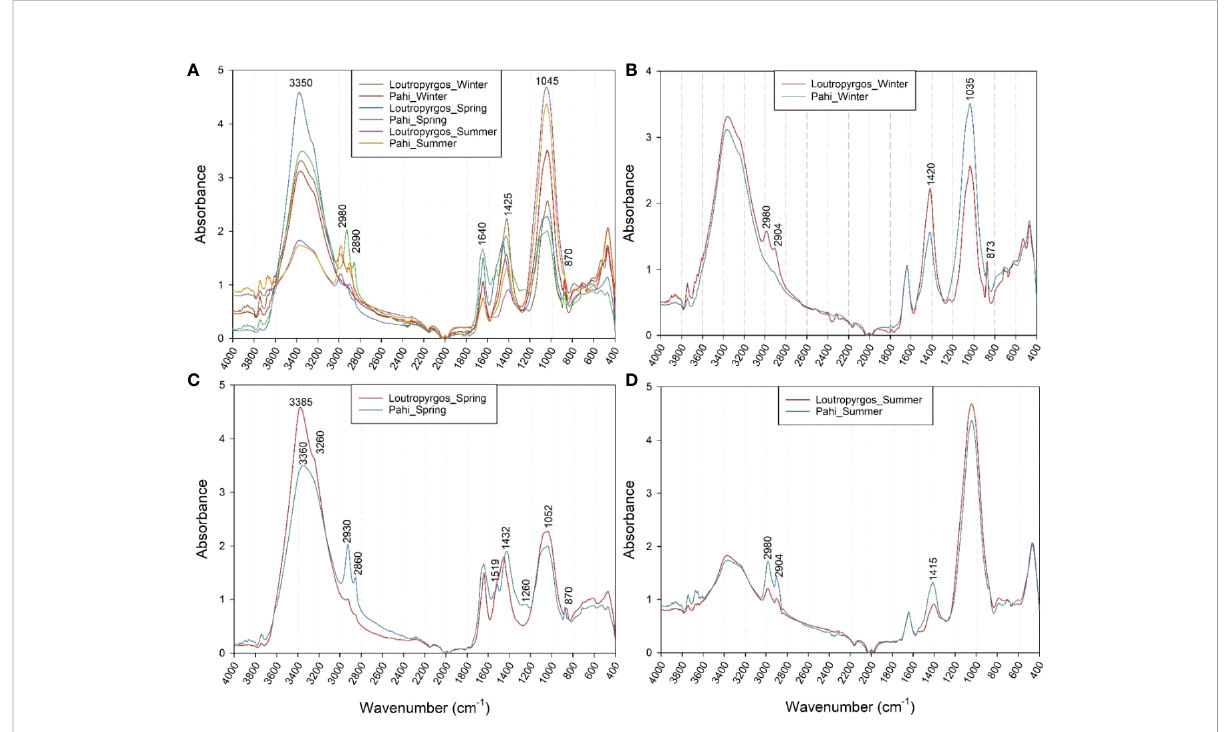
FIGURE 3 ATR-FTIR spectra of (A) all SML water samples collected from both sites, and their comparison according to the sampling period, i.e., during (B) winter, (C) spring and (D)